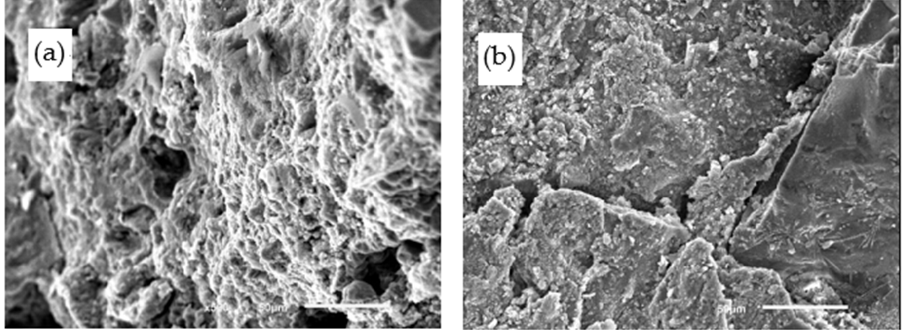
Figure 12. Microstructures of 4% SF PCPC. ( a ) Without wet-dry cycle and ( b ) with 12 wet-dry cycles in acid rain solution.